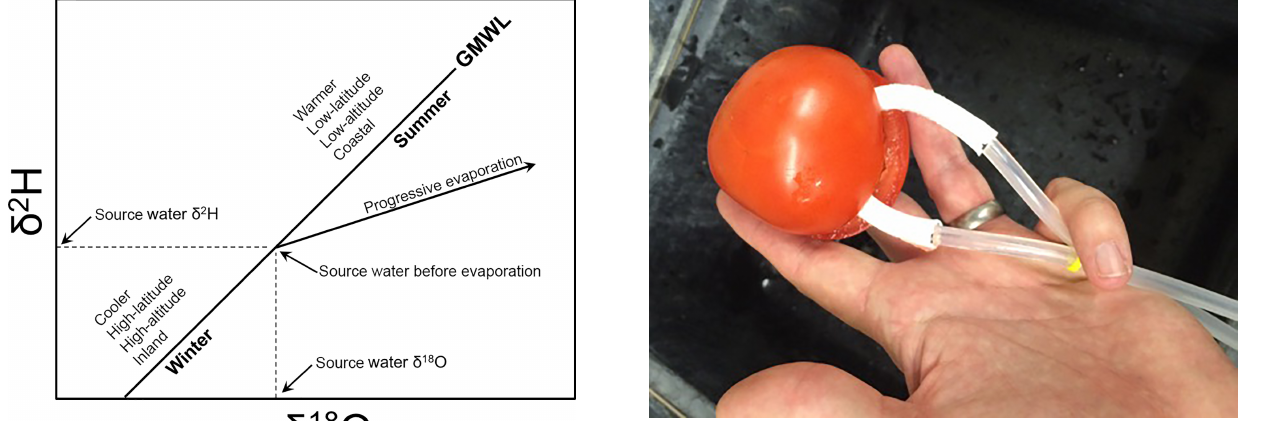
Figure 2. Photograph of membrane-inlet probe (opaque white tub- ing) partially inserted into a